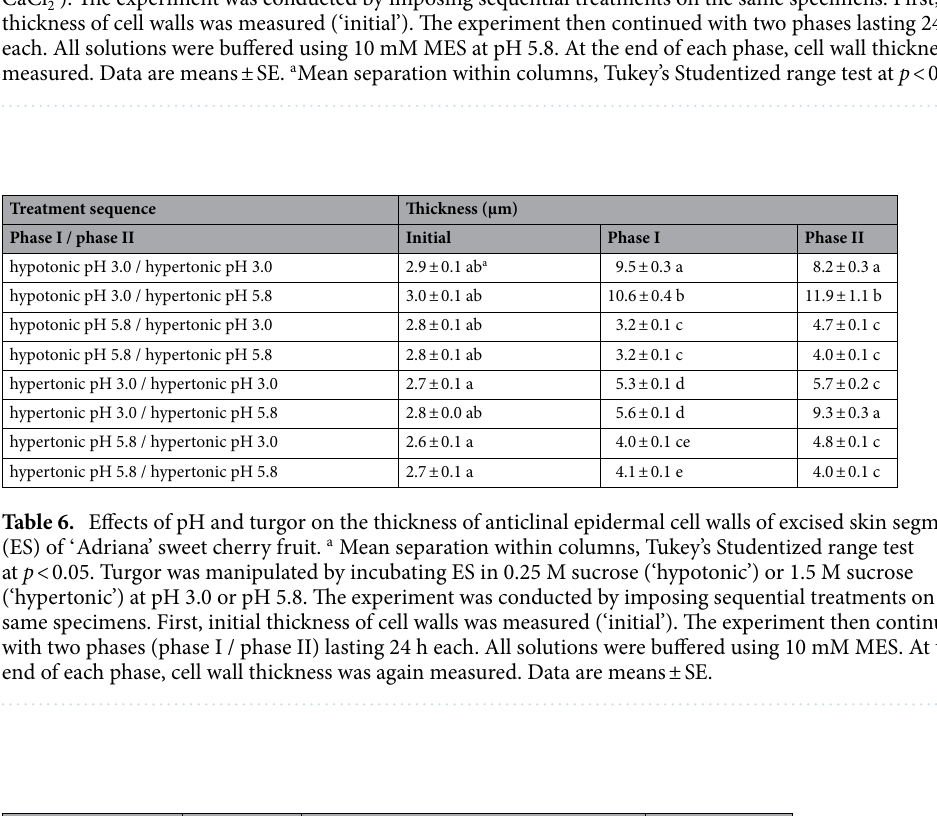
Treatment pH CaCl 2 Sucrose